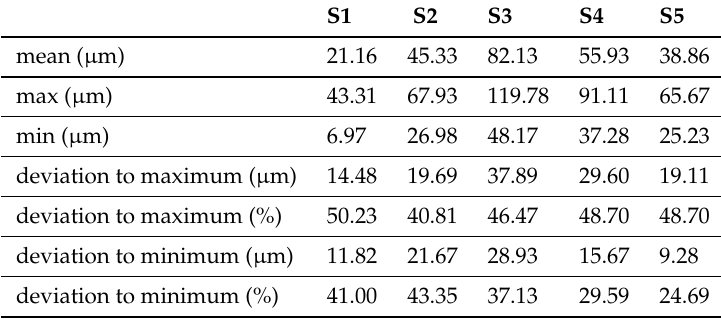
Table 1. Coating thickness of five struts (S1–S5) measured in 33 micro-sections along the length of a strut and along six measuring points (MP) per micro-section.